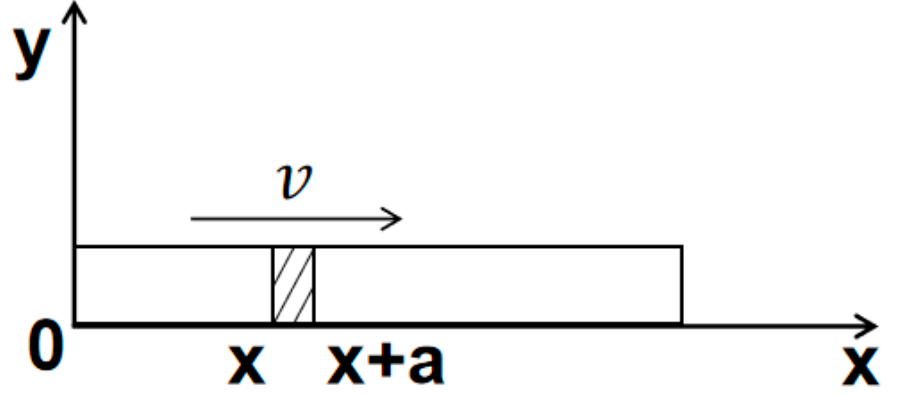
Figure 3. Schematic diagram of heat release of the heat source of thermal battery.